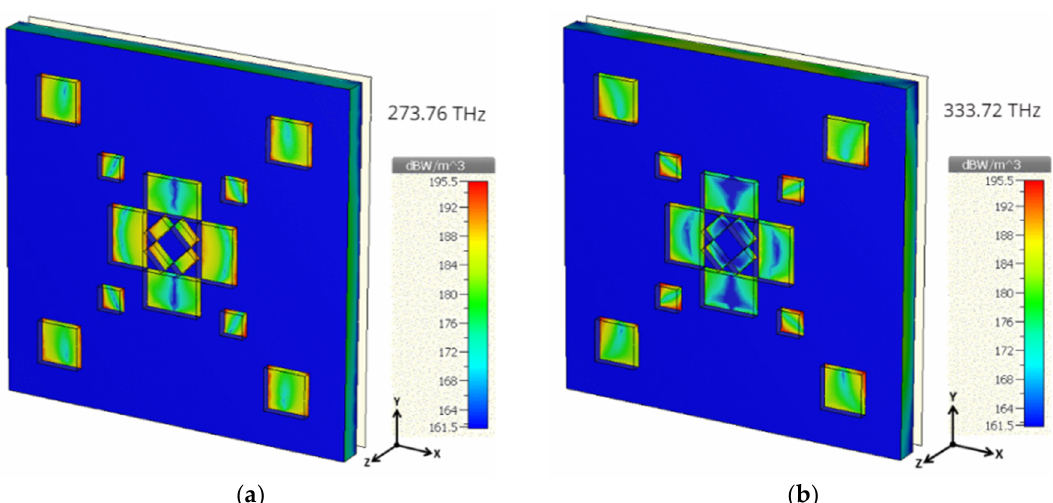
Figure 12. Power loss distribution at ( a ) 273.76 THz and ( b ) 333.72 THz.